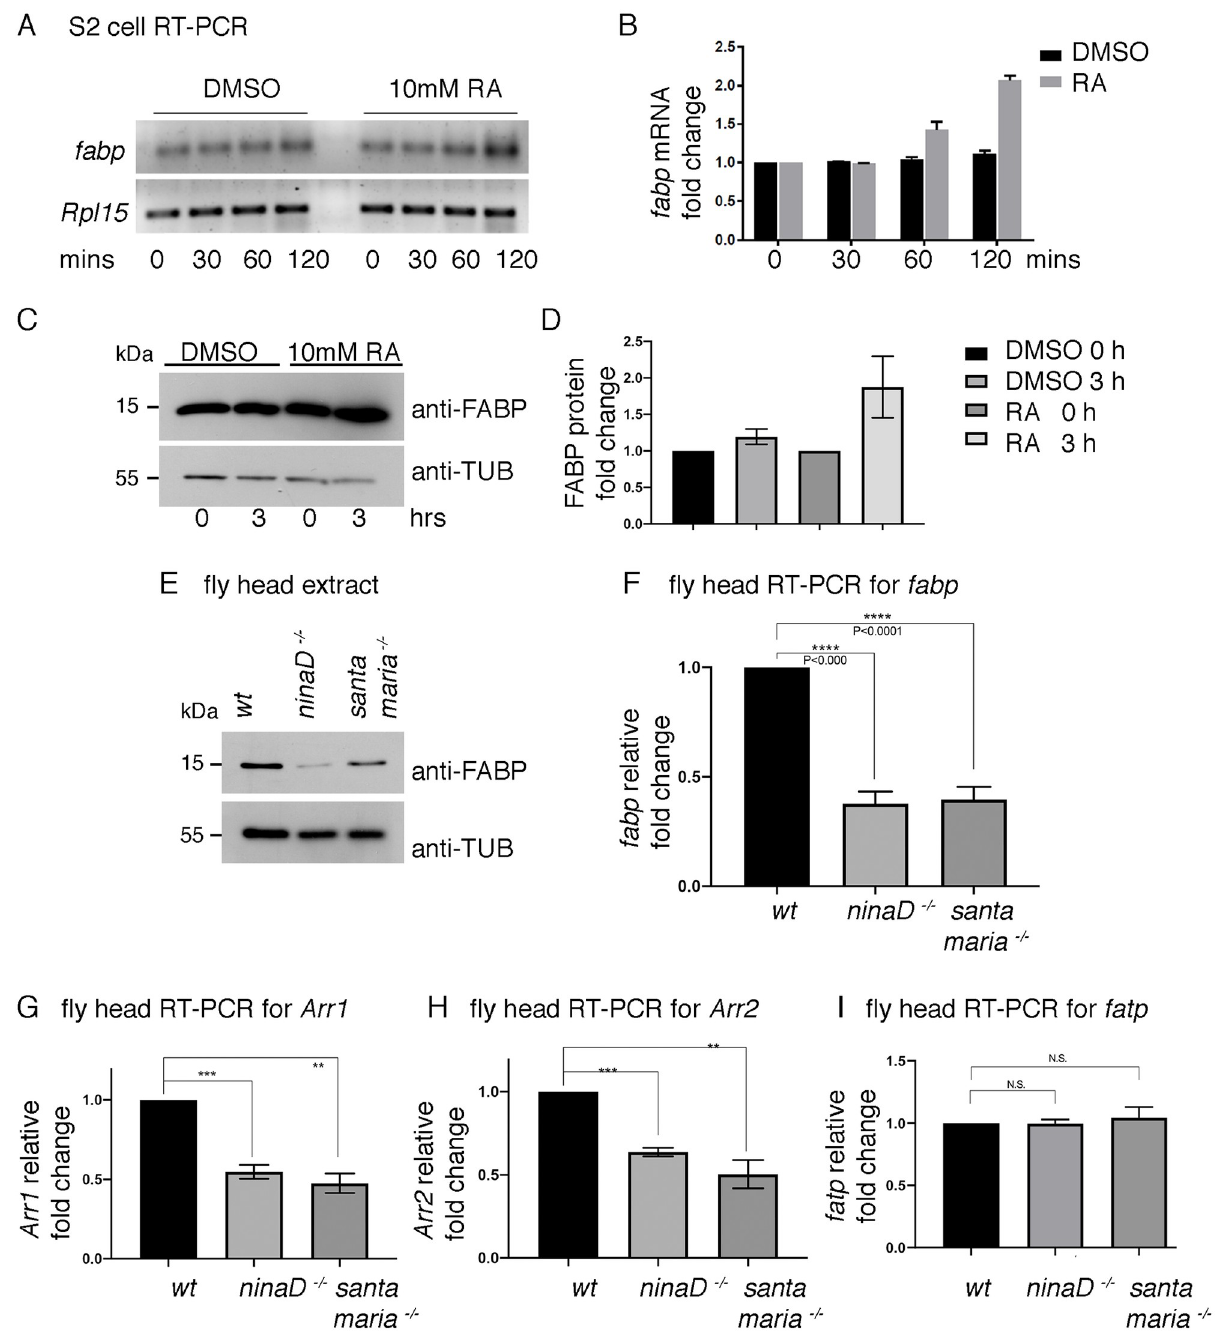
Fig 2. fabp expression is regulated by carotenoids and retinoic acid. (A) The time course of fabp mRNA induction as assessed through semi- quantitative RT-PCR for fabp (top gel) and the control Rpl15 (bottom gel). Cultured Drosophila S2 cells were treated with either control DMSO (left 4 lanes) or with 10mM all-trans retinoic acid (RA, right 4 lanes) for the indicated periods of time. (B) q-RT-PCR of fabp from S2 cells treated with DMSO (black) or 10mM all-trans retinoic acid (grey bars) for the indicated period of time. The y axis shows fold induction as compared to the results from the DMSO controls. (C) Western blot of FABP (top gel) and β -Tubulin (bottom gel) from S2 cell extracts exposed to control DMSO (lanes 1, 2) and 10mM RA (lanes 3, 4) for the indicated time periods. (D) Quantification of relative FABP protein band intensities from (C). (E) Western blots for FABP (top) and Tubulin (bottom) from adult fly head extracts of the indicated genotypes. w 1118 flies were used as wild type controls. (F-I) q-RT-PCR-based assessment of indicated mRNAs from adult fly heads of the indicated genotypes. The levels of fabp (F), Arr1 (G), Arr2 (H), fatp (I) are shown. The y axis shows fold changes compared to results obtained from wild type control samples. In all q-RT-PCRs, RpL15 q-RT-PCR results were used to normalize the levels of transcripts of interest. Error bars represent standard error (SE). Statistical significance was assessed through two tailed t-tests. �� = p < 0.005, ��� = p < 0.0005, ���� = p <